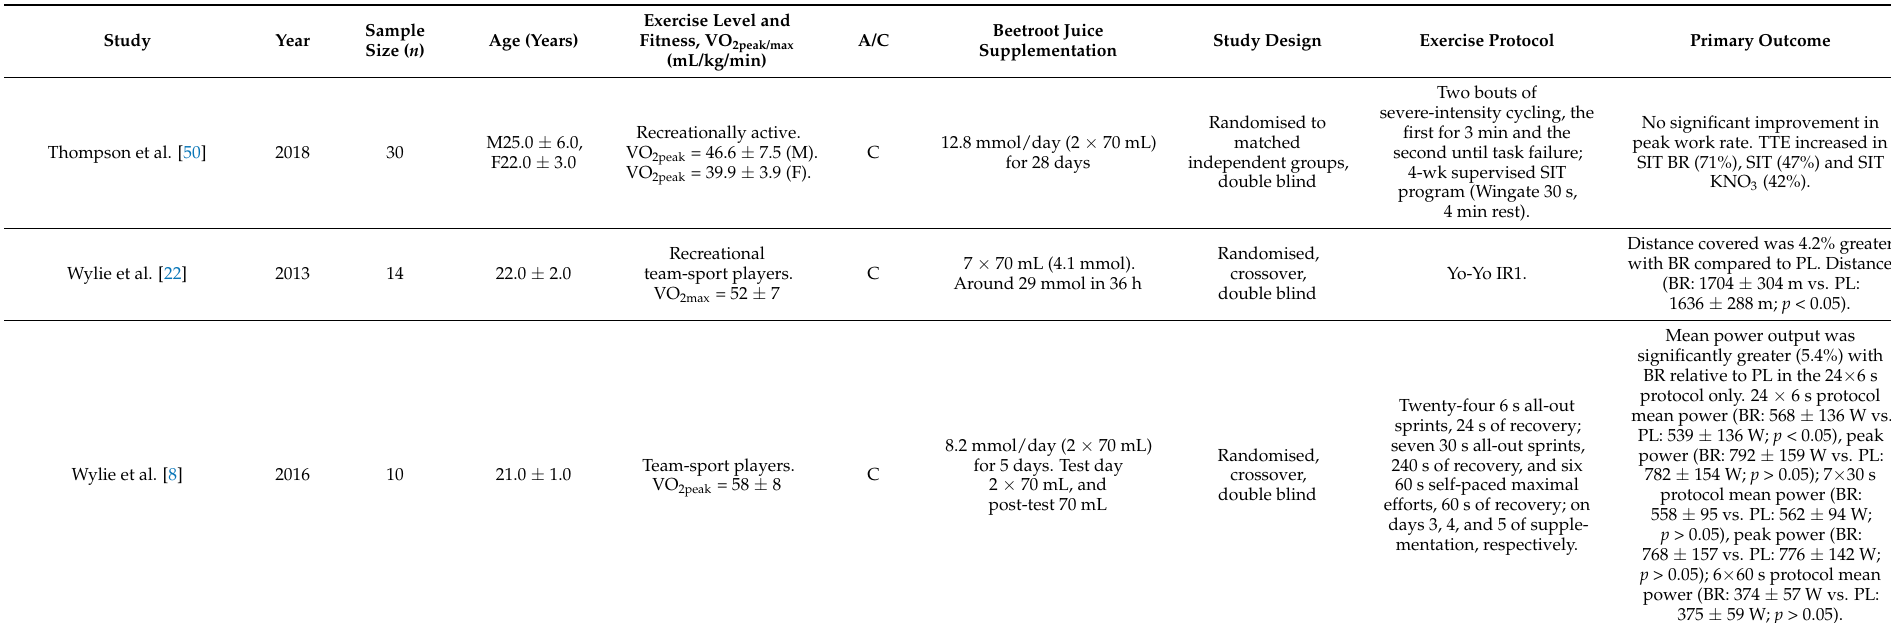
Study Design Exercise Protocol Primary Outcome